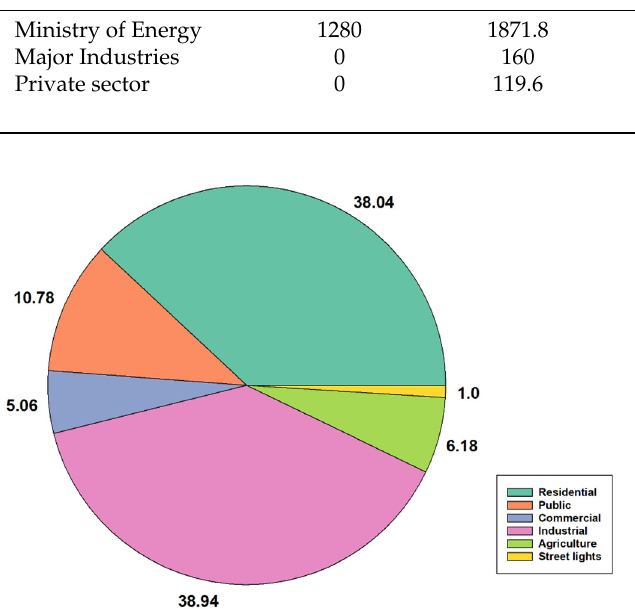
Figure 2. Breakdown of sectors’ energy consumption in 2017 [22]. Due to its location at low latitudes, the southern regions of Iran, including Hormozgan, favors a very high potential of solar energy within the country, where the global solar irradiation ranges between 863 to 2456 kWh/m 2 /year, a prominent value [23]. In contrast, although the potential of wind energy in Hormozgan is not as strong as the solar potential, it is to an extent that cannot be ignored. Therefore, the study area is one of the most suitable regions in the country for harvesting both wind and solar power [24,25]. Figure 3 depicts the heat map for annual solar GHI and wind speed of Hormozgan.